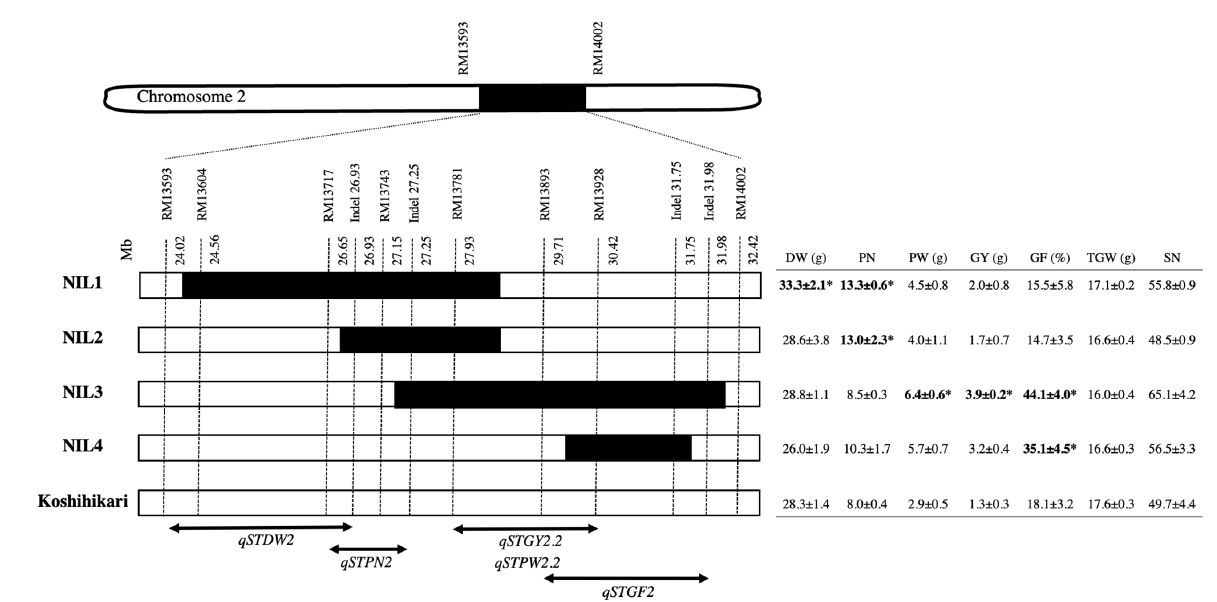
Figure 5. Graphical genotypes of near-isogenic lines (NILs) and their grain yield and ancillary traits under salt stress conditions in 2018. Black and white bars indicate chromosome segments for homozygous IR64 and Koshihikari, respectively. Values are mean ± standard error (n = 4). * indicates a significant difference between Koshihikari and NILs at a 5% level by Dunnett’s test.